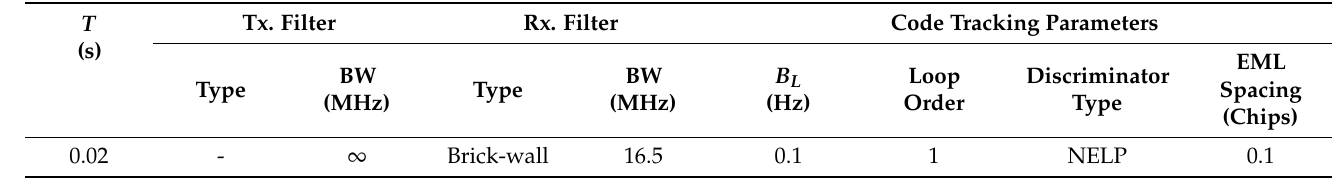
Table 6. Receiver parameters used in the delay-locked-loop (DLL) error analysis (also used in the Gabor bandwidth and multipath error